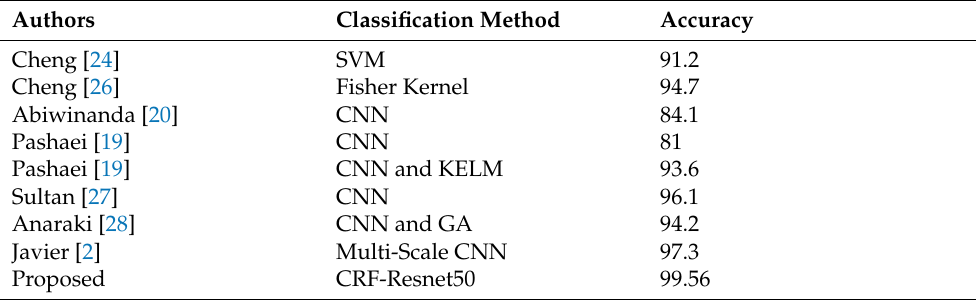
Table 5. Comparison of Three class